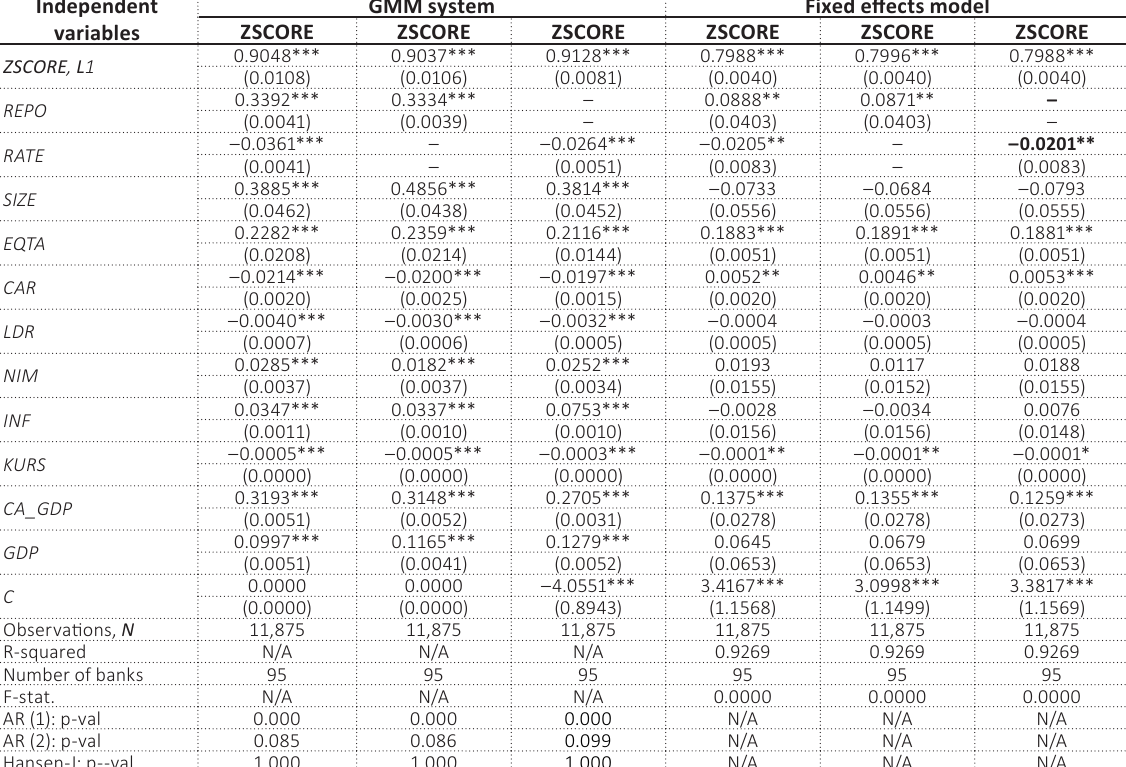
Table 3. Effect of monetary policy/interest rate ( REPO or RATE ) on the risk of banking stability ( ZSCORE ) Independent GMM variables